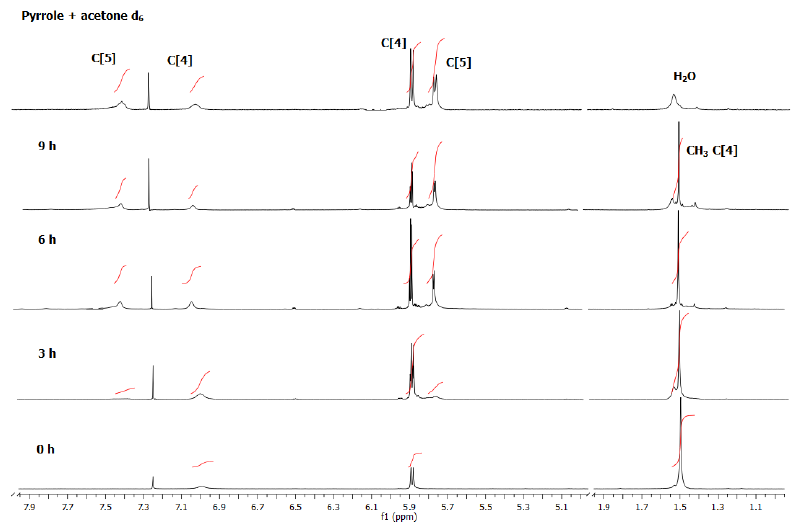
Figure 2. 1 H NMR spectra over the course of the reaction of pyrrole with acetone d room temperature after work up. Spectra were collected at different reaction times in CD Cl. At the top a mixture of the two calix compounds deuterated at all of their CD 3 positions is